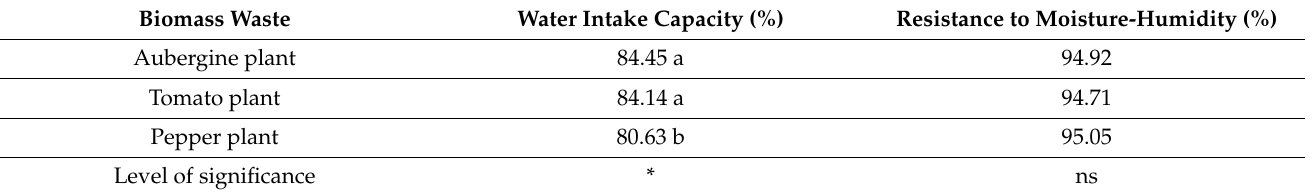
Table 6. The resistance to moisture-humidity, water intake capacity, and variance analysis results of obtained briquettes. (on